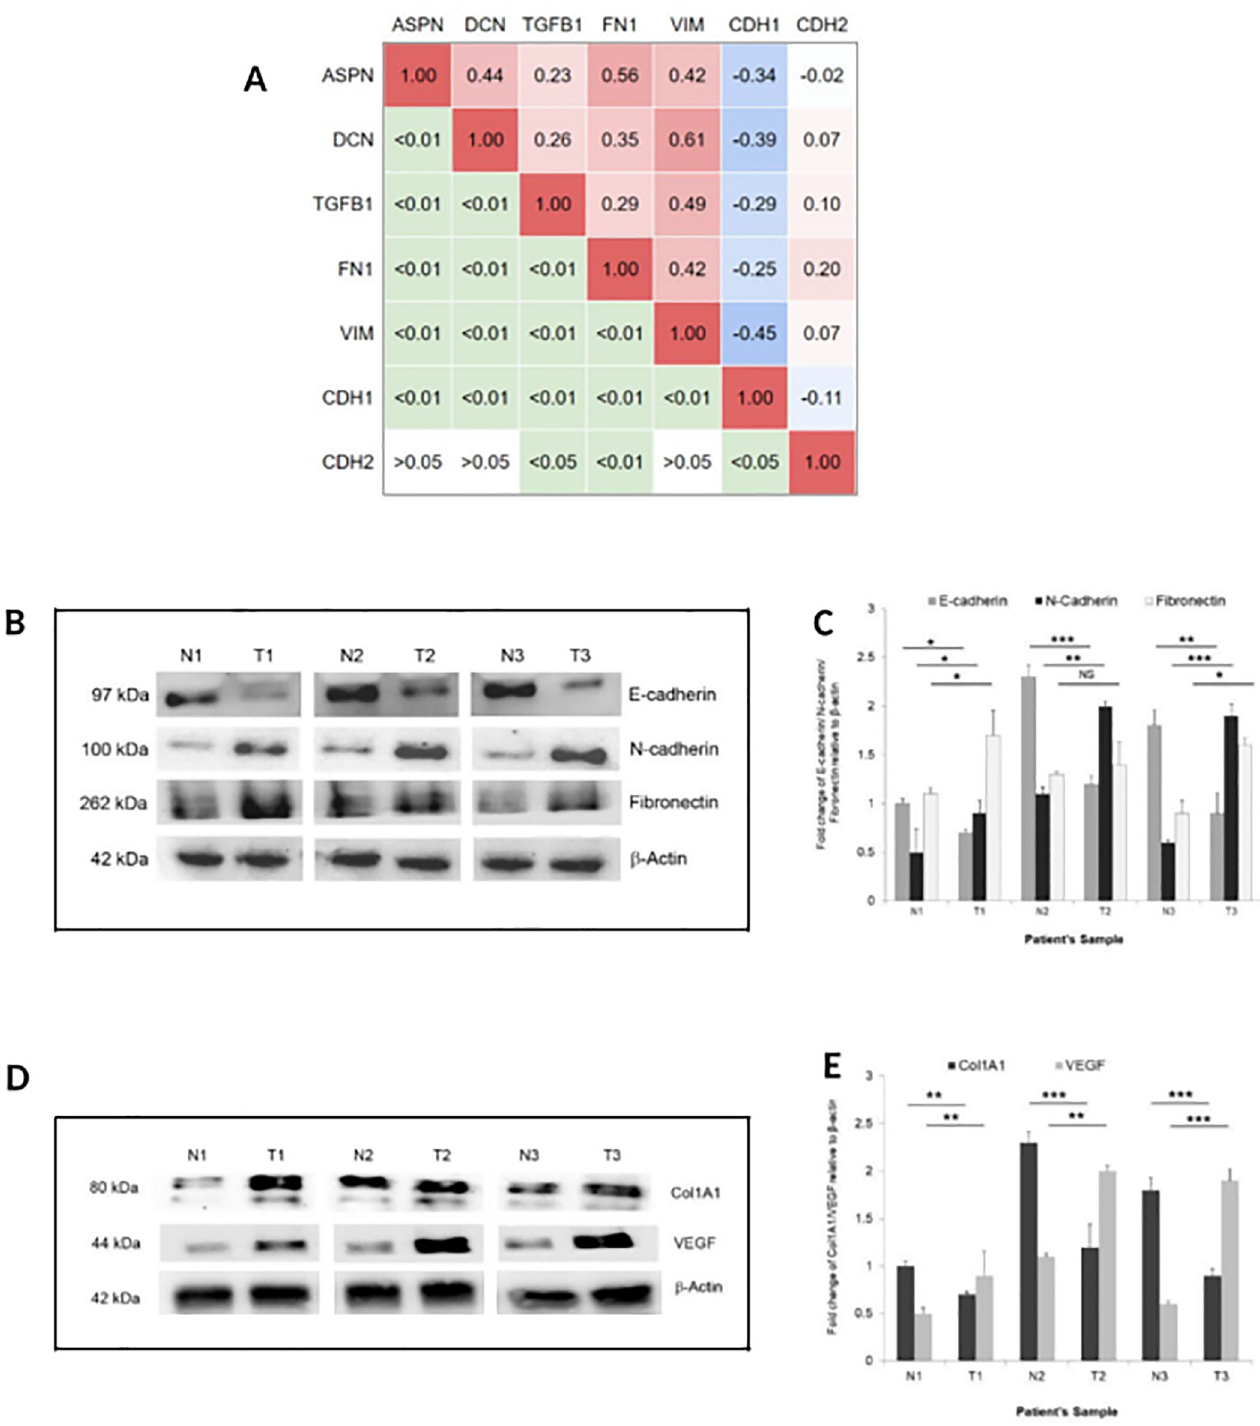
Fig 6. Correlation between the SLRPs and EMT. (A) Correlation Matrix of ASPN, DCN, TGF β , and several EMT genes on TCGA-STAD data. The right half of the matrix represents Pearson’s correlation coefficient values. The left half of the matrix represents P-values. (B, C) Western blot analysis of E-cadherin, N- cadherin, and fibronectin. Data were quantified, normalized with β -actin and plotted (n = 3, mean ± SD, � p � 0.05, �� p � 0.01, ��� p � 0.001, student’s t- test). (D, E) Expression of angiogenesis marker Collagen (Col1A) and vascular endothelial growth factor (VEGF) in gastric tumor and adjacent normal tissue using western blot assay. T1, T2, T3 are tumor tissues and N1, N2, and N3 are respective corresponding normal tissues. Data were quantified, normalized with β - actin and plotted (n = 3, mean ± SD, � p � 0.05, �� p � 0.01, ��� p � 0.001, student’s t- test).